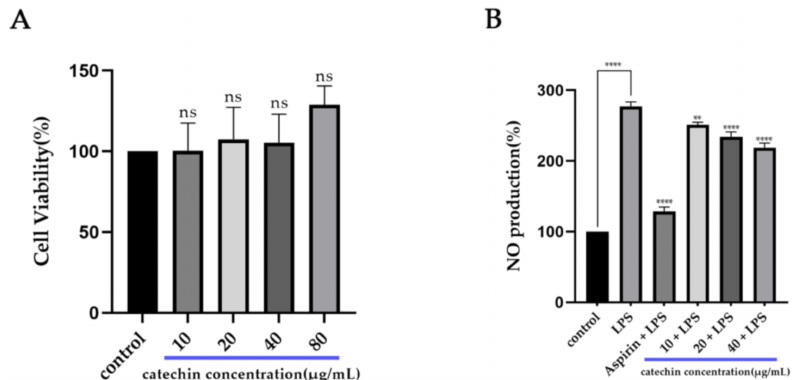
Figure 1. Anti-inflammatory effect of catechin on RAW264.7 cells. ( A ) Cell viability. NS means no